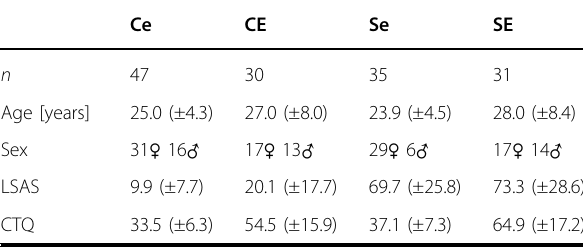
Table 1 Sample characteristics for the four